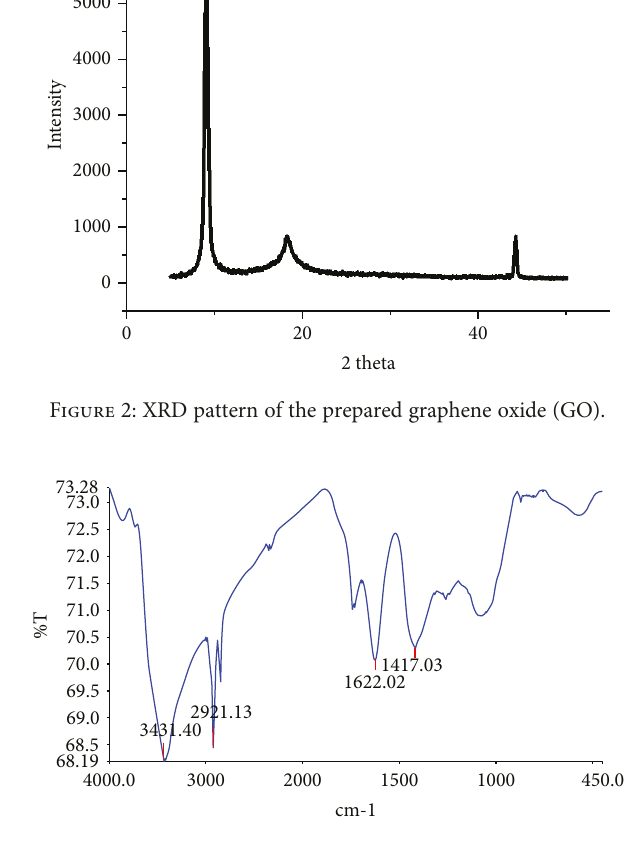
Figure 3: FTIR spectra of the prepared graphene oxide (GO).